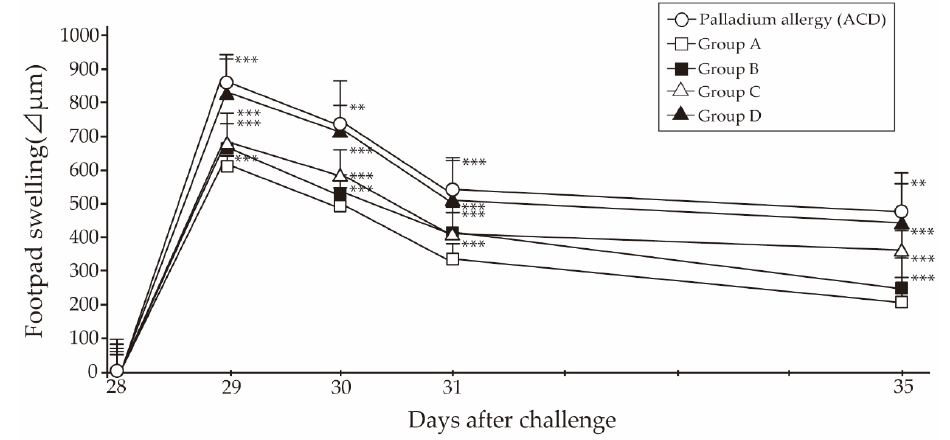
Figure 2. Effect of fexofenadine hydrochloride and prednisolone on footpad swelling with Pd induced allergy. Fexofenadine and prednisolone were orally administered to Pd-induced ACD mice at 1 h